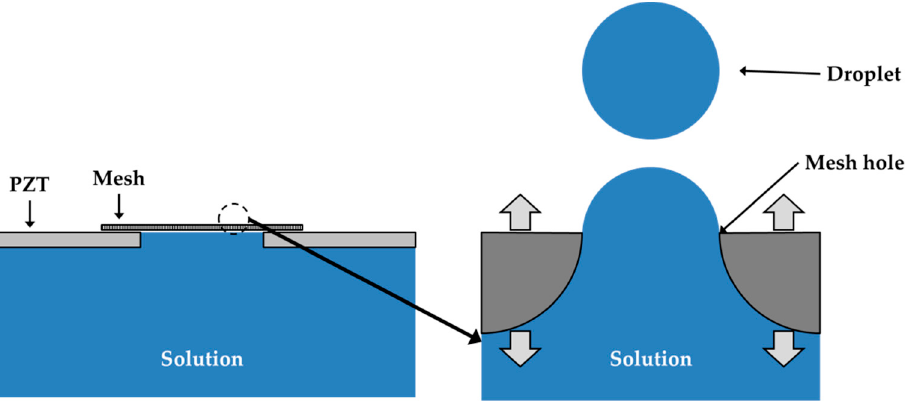
Figure 1. Vibrating mesh nebulizer working principle.